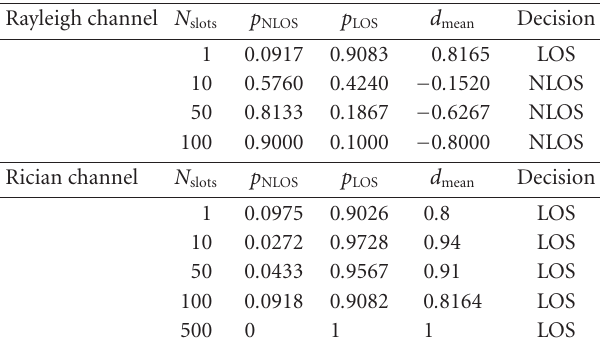
Table 2: Probabilities of accepting a certain distribution using Ri- cian factor-based algorithm. Rayleigh and Rician channel ( K r = 15dB) and v = 22 .